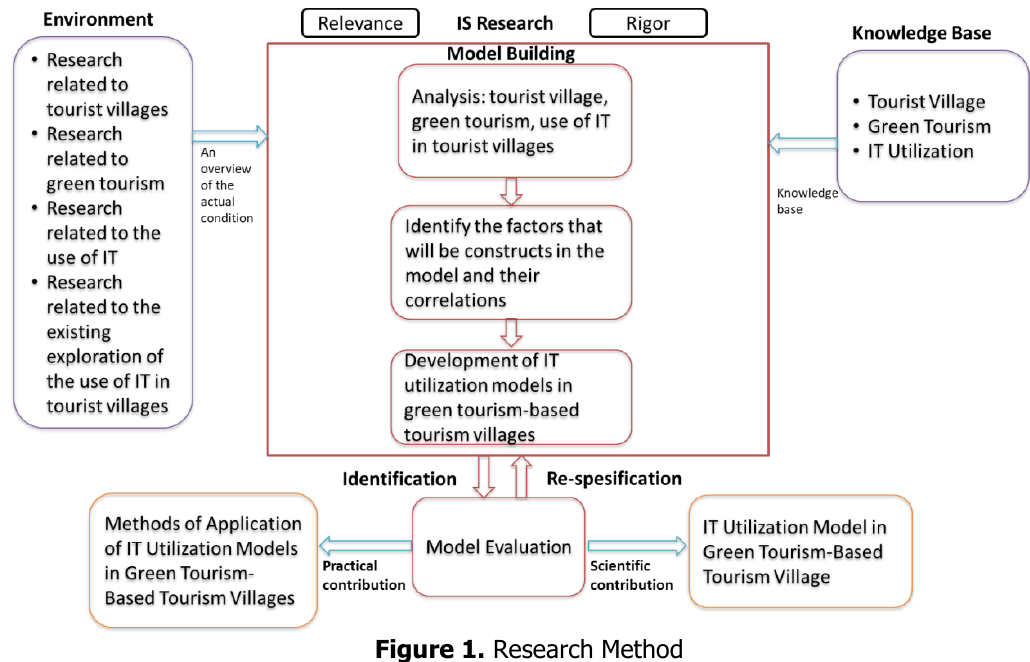
Figure 1. Research Method